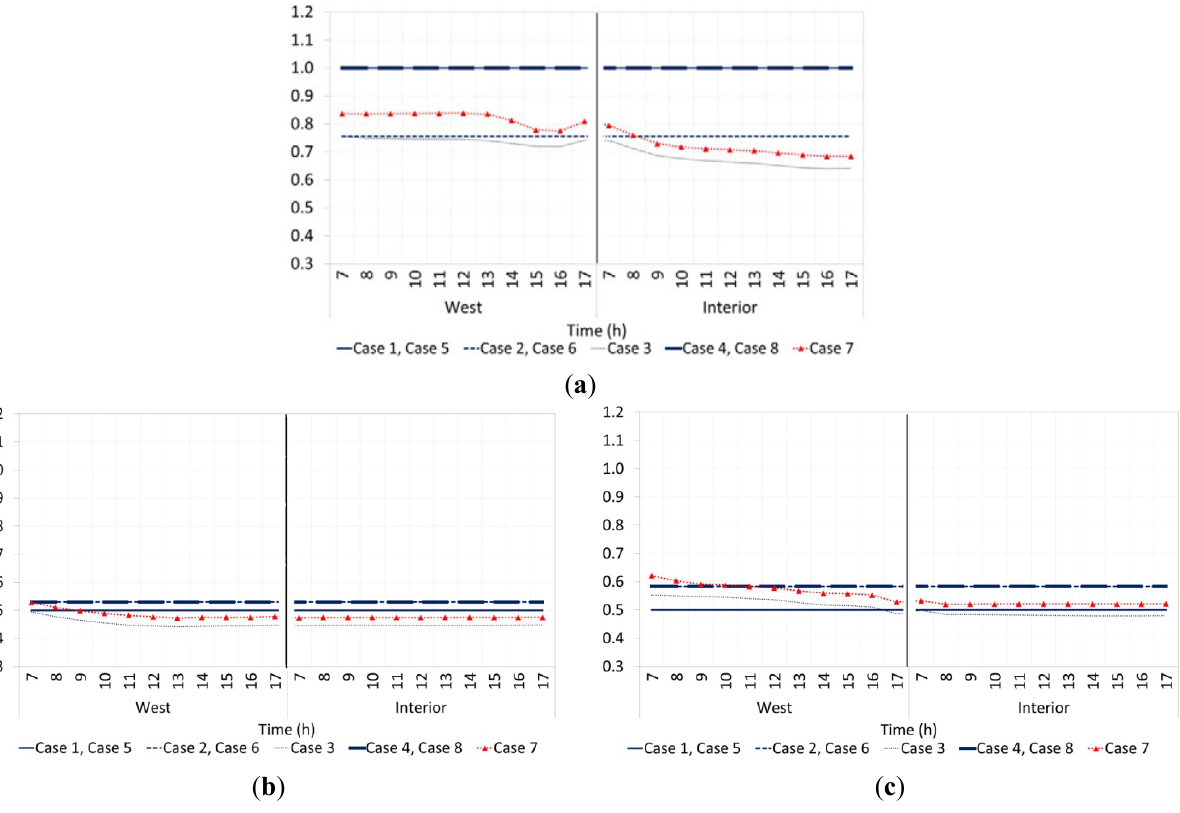
Figure 3. Hourly clothing insulation variations (Middle floor). ( a ) Winter season